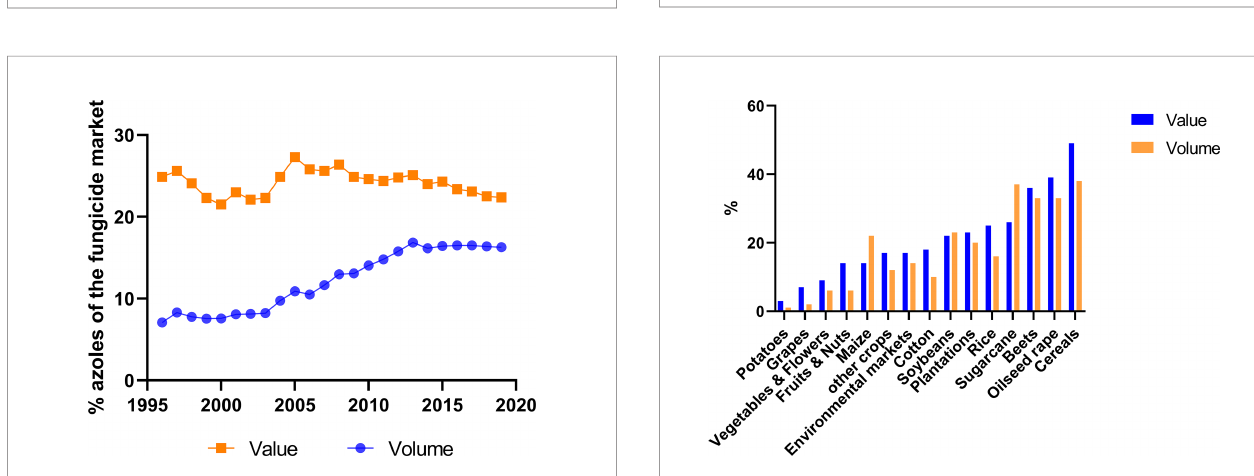
FIGURE 1 | Amounts of agricultural azoles product (tons) and their market value ( € ) measured during 24 years (source: Bayer Internal Source).